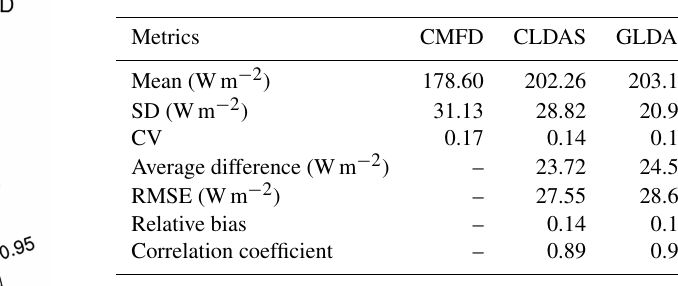
Table 5. Statistical metrics describing the spatial average and vari- ability of annual mean shortwave radiation during 2008–2014, along with the average difference, RMSE, bias and correlation co- efficient relative to